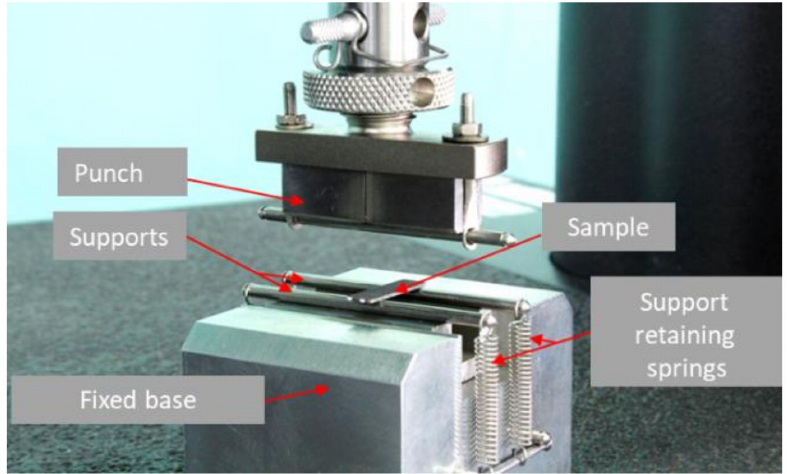
Figure 2. Outer view of the device for three-point